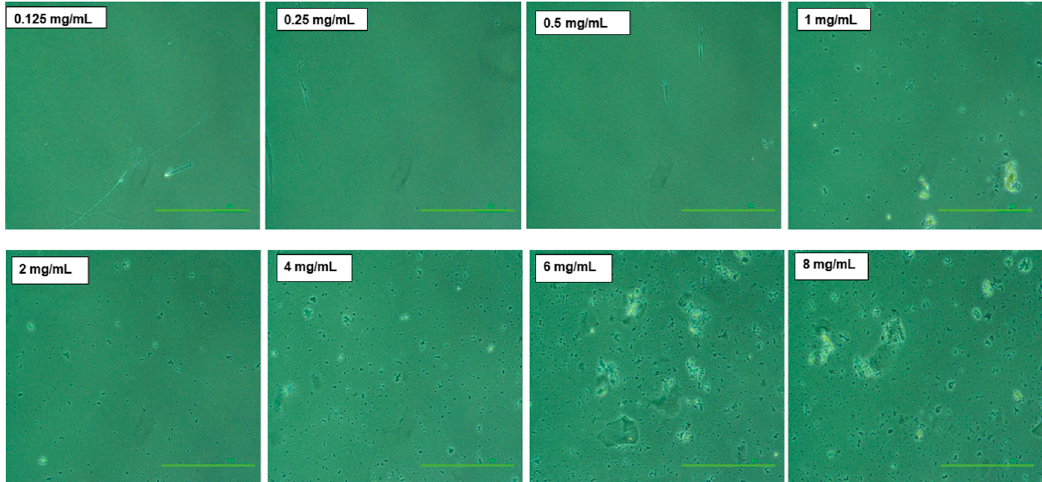
Figure 4. Microscopic images of the aggregates of NaCNs (formulated at different concentrations of sodium caseinate) taken after one hour of mixing time. Scale bar: 100 µ m and a magnification: 10×.